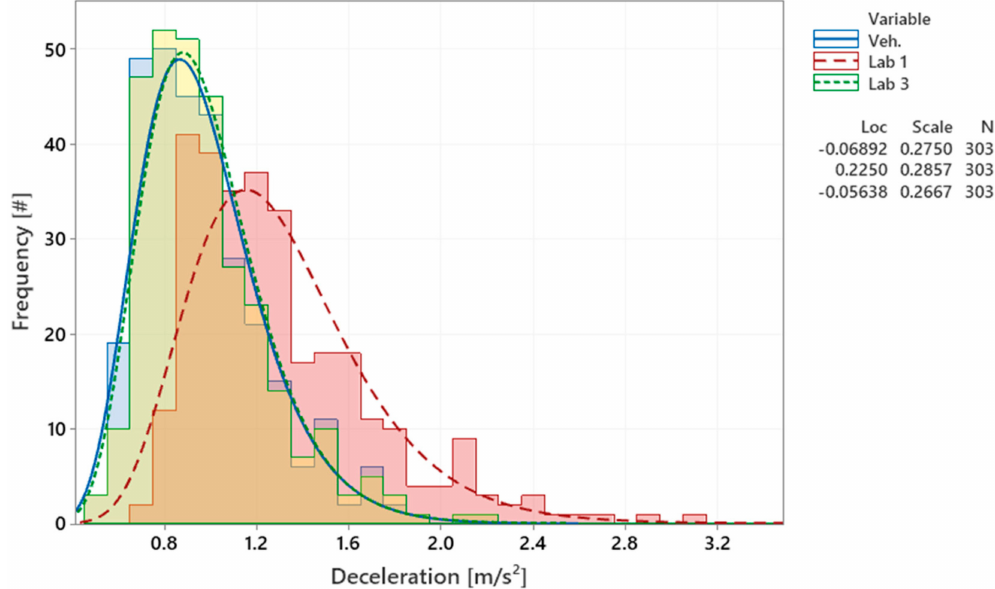
Figure 3. Histograms for all decelerations during T1-R1 for Lab 1 and Lab 3 and the nominal WLTP–brake cycle—the continuous lines represent the lognormal distribution for each dataset.